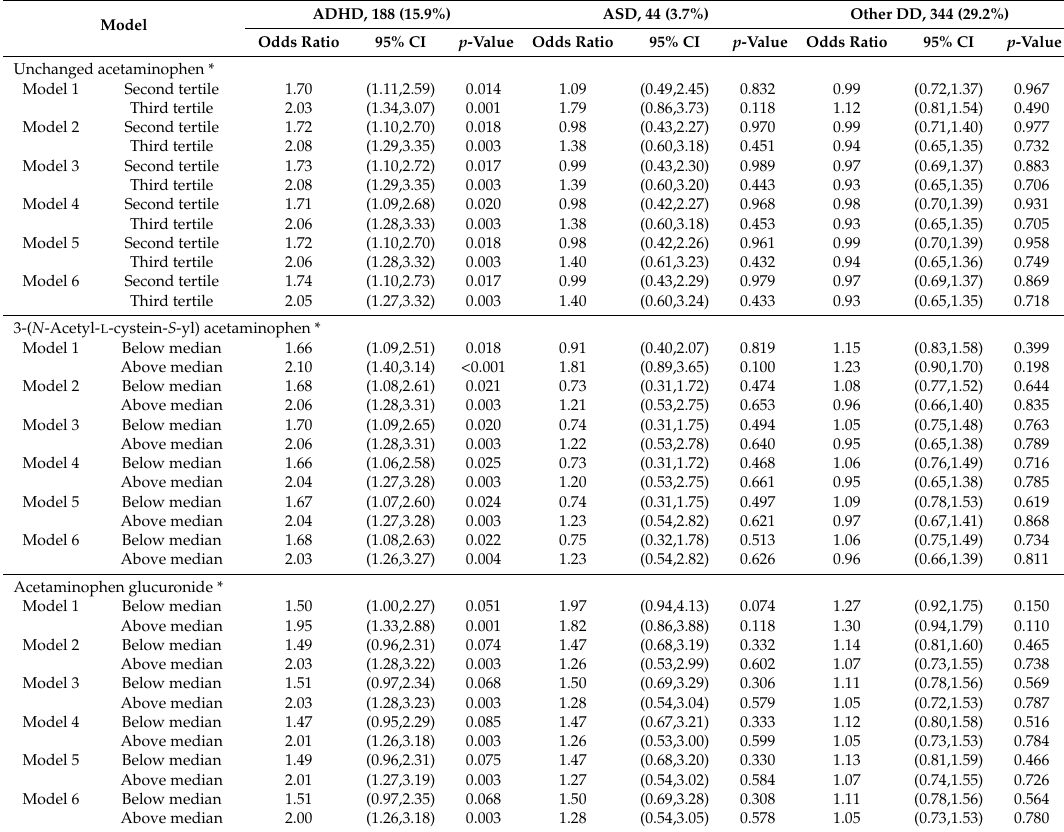
Table 2. The association between maternal acetaminophen metabolites and the risk of ADHD diagnosis, ASD diagnosis (excluding ADHD), and other DD diagnosis in